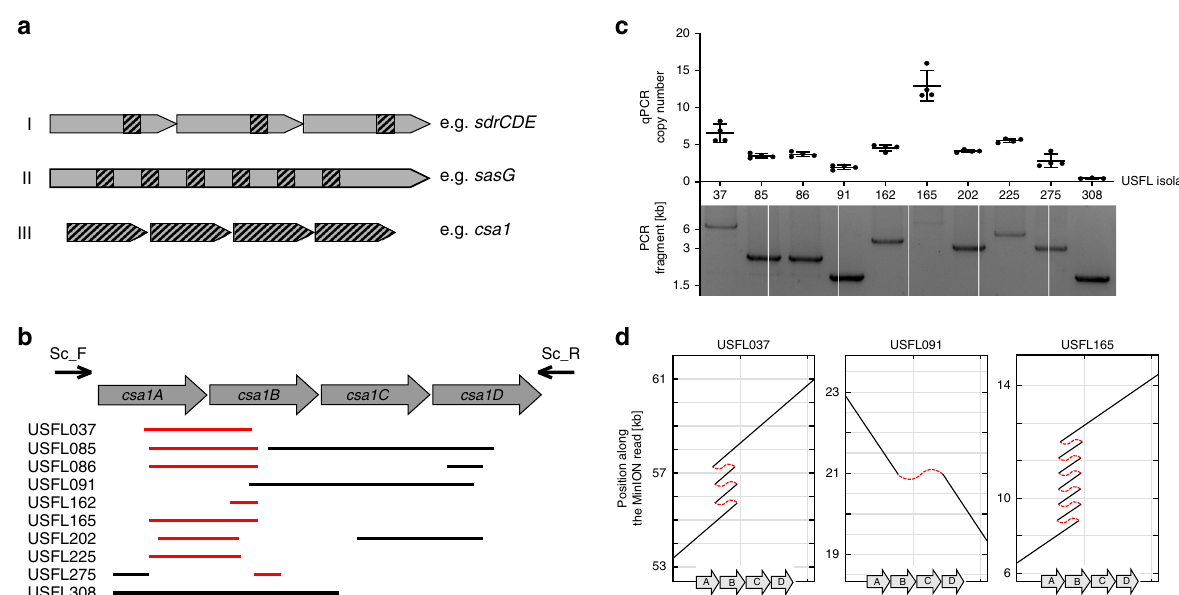
Fig. 1 csa1 gene copy number variation within the csa1 locus of S. aureus USA300 isolates. a Schematic diagram of the three categories of repetitive sequences creating copy number variation. Hatched areas denote regions of homology. b Schematic representation of the deletions and putative ampli fi cations of csa1 in different isolates. Coding sequences are indicated. Red and gray lines represent increased coverage (>2 fold) or deletions within the USFL isolates, respectively. c The upper panel shows the csa1 copy number of the indicated clinical isolates as measured by qPCR. Mean and SD of four replicate qPCRs on a single DNA isolation is shown. The lower panel shows DNA fragments ampli fi ed by conventional PCR using primers csa1_Sc.F and csa1_Sc.R indicated in ( b ). The experiment was performed once using the same batch of DNA used for qPCR. Source data are provided as a Source Data fi le. d USFL isolates were sequenced using MinION technology. For each sequenced isolate, a single long read that is aligned against the csa1 locus of USA300 FPR3757 is shown. Tandem ampli fi cations manifest as multiple regions within the read with homology to csa1 , allowing calculation of gene copy number. Hatched red lines emphasize that a single long read mapping repeatedly to the csa1 genes is analyzed. Genes csa1A , csa1B, csa1C , and csa1D are indicated. Shown are read_ch:51530_110 (USFL037); read_ch:10493_161 (USFL091); read_ch:40122_41 (USFL165). Source data are provided as a Source Data fi